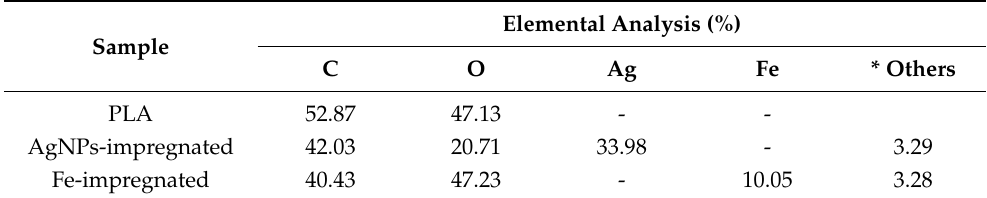
Table 1. Elemental analysis (%) of PLA and impregnated samples.